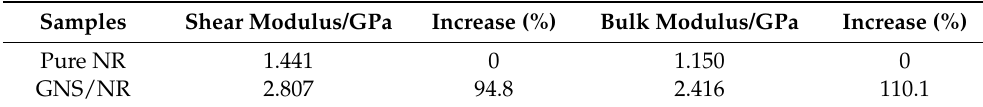
Table 1. Mechanical properties of the pure natural rubber and the graphene/natural rubber composites.